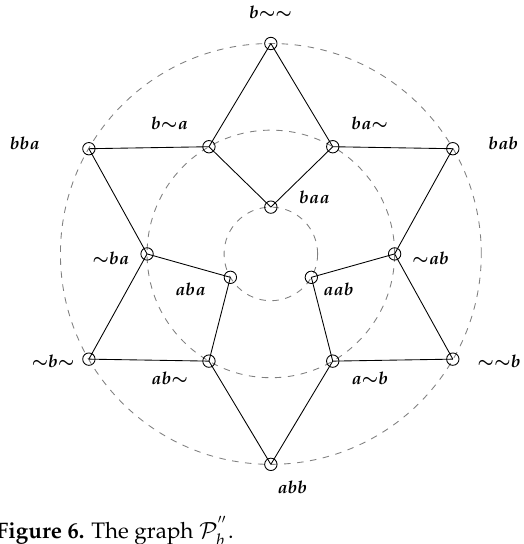
Figure 6. The graph